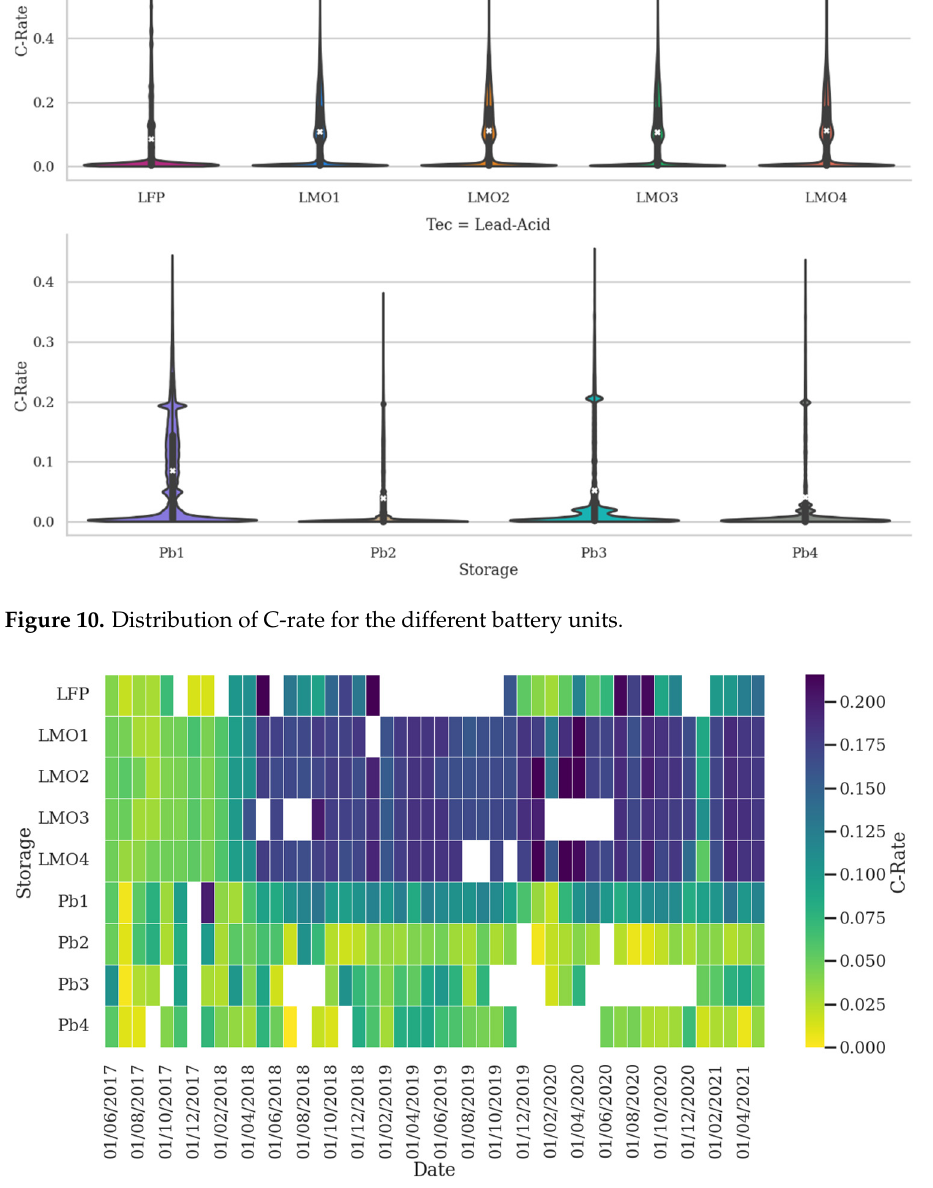
Figure 11. Monthly average C-rate of the battery units.